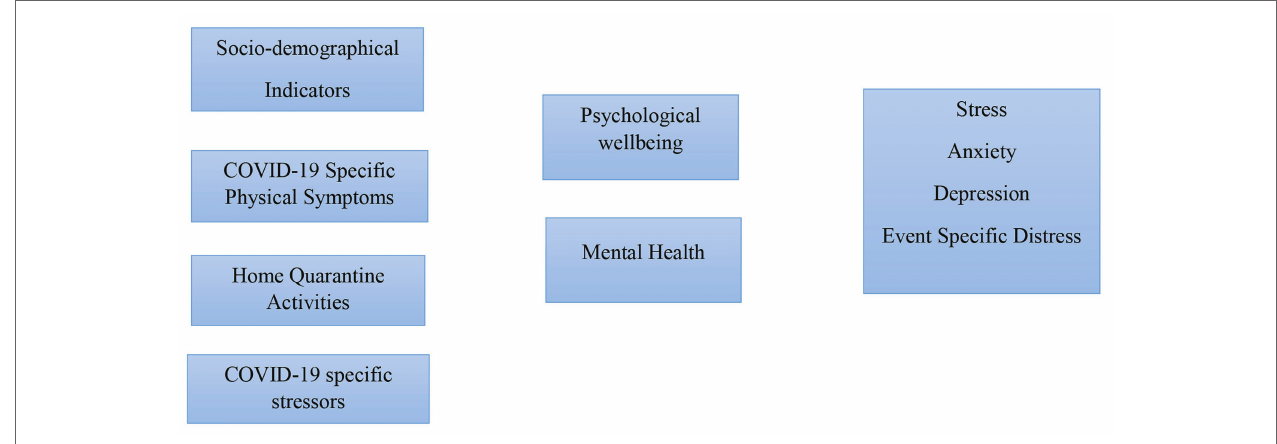
FIGURE 1 | Covid-19 pandemic and university student study